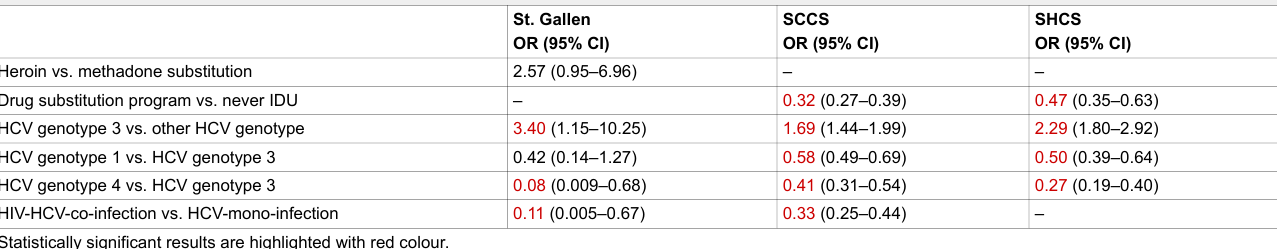
Table 3: Logistic regression derived odds ratios for treatment uptake.